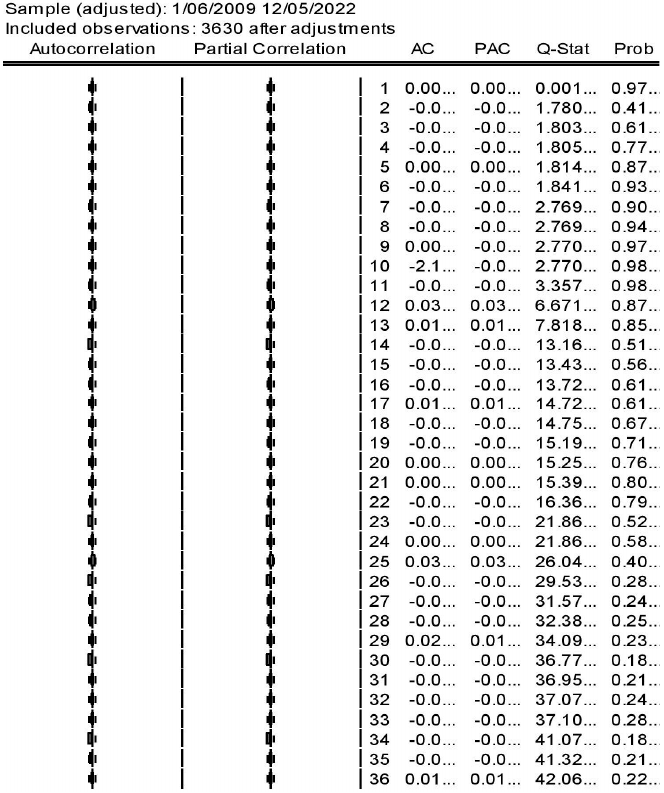
Figure 4. Actual, Fitted, Residual Graph of OLS Regression on Gold Price Returns. The highest volatility in gold price residuals is captured in the month of July when the number of confirmed cases of COVID-19 cases reached 1 million. The residual graph of LS regression also shows signs of significant volatility clustering which is imperative in applying GARCH models. Indeed, the correlogram plot of the residual series in Figure 5 with no significant spikes support that the error terms are white noise.